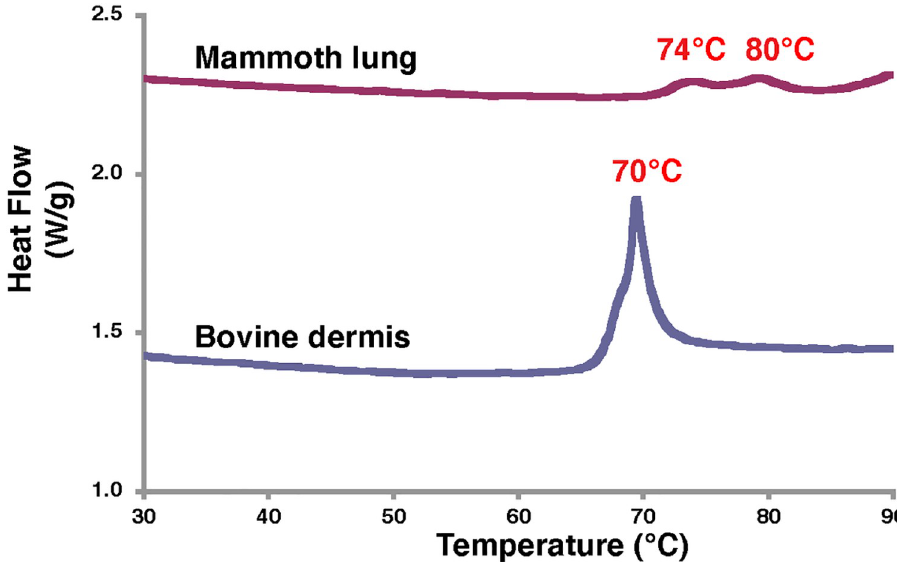
Fig 7. DSC analysis data of lung tissue from Masha and bovine